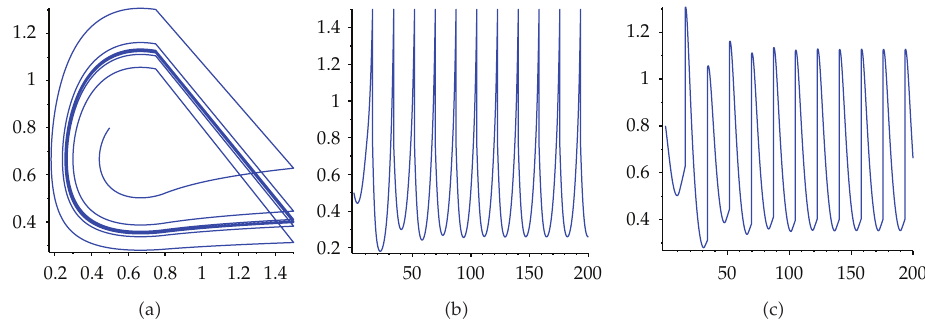
Figure 13: The time series and phase diagram for system (cid:4) 1.4 (cid:5) starting from initial value (cid:4) 0.4,0.5 (cid:5) , α (cid:8) 0 . 5 , β (cid:8) 0 . 2 , q (cid:8) 0 . 8 , h (cid:8) 1 . 5 , x 0 (cid:8) 0 . 8 , x ∗ < x 0 < h